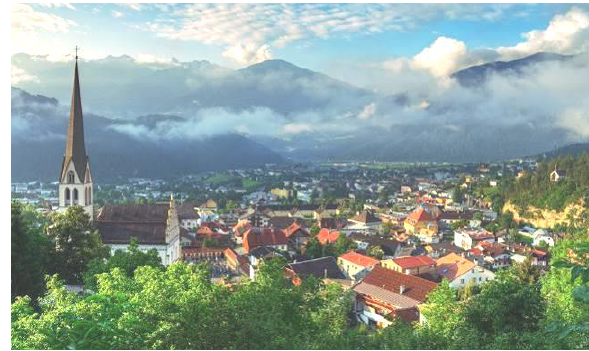
Figure 1. View of the project area (© Edgar Moskopp, 2014).